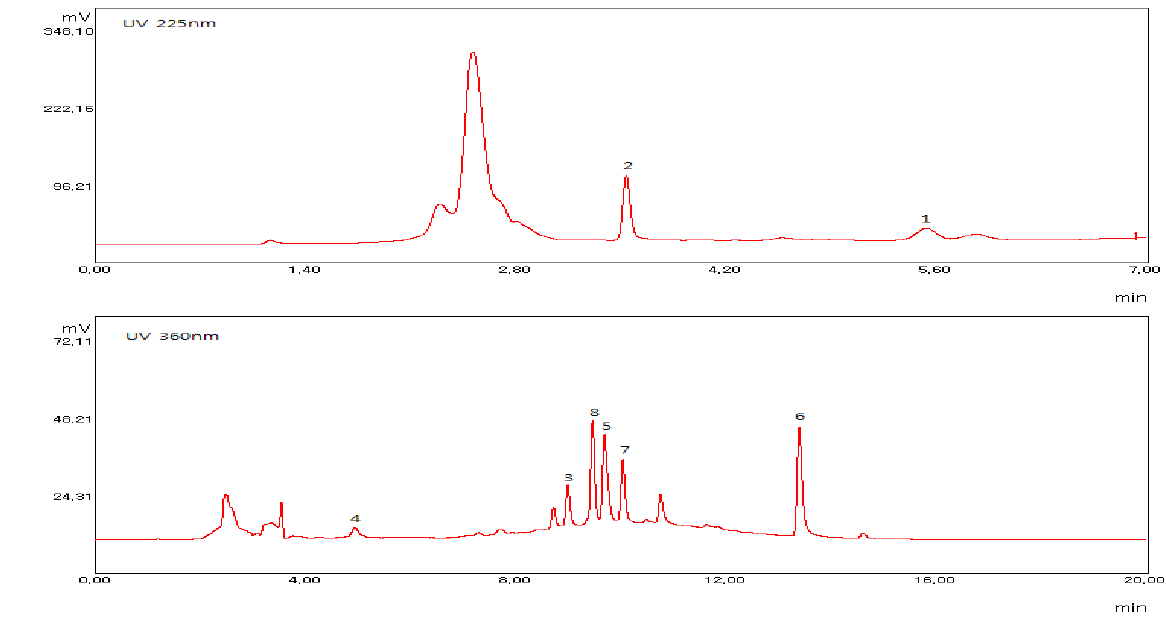
Figure 2. HPLC chromatograms of RRS extracts.